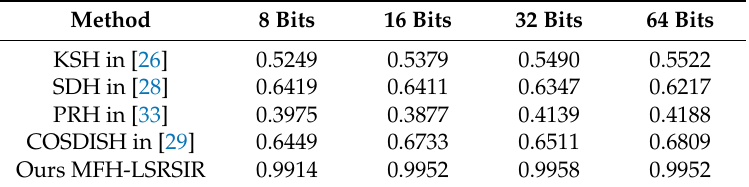
Table 4. Comparison MAP scores for different methods with varied hash bits in the SAT-4